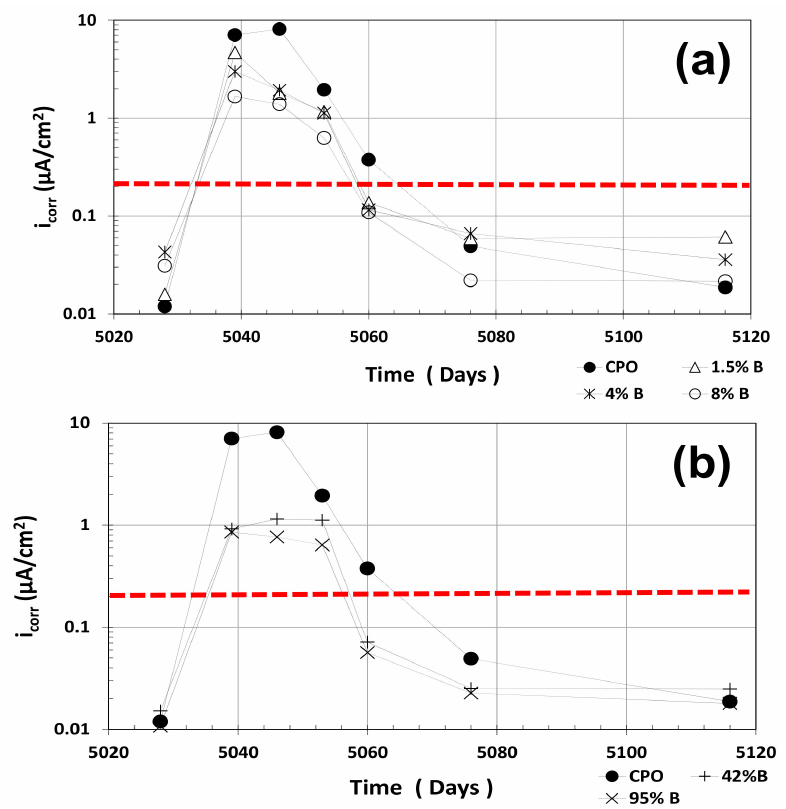
Figure 4. Average corrosion rate estimates (i corr ) vs. time: ( a ) control vs. low OFI mucilage concen- tration; ( b ) control vs. high OFI mucilage